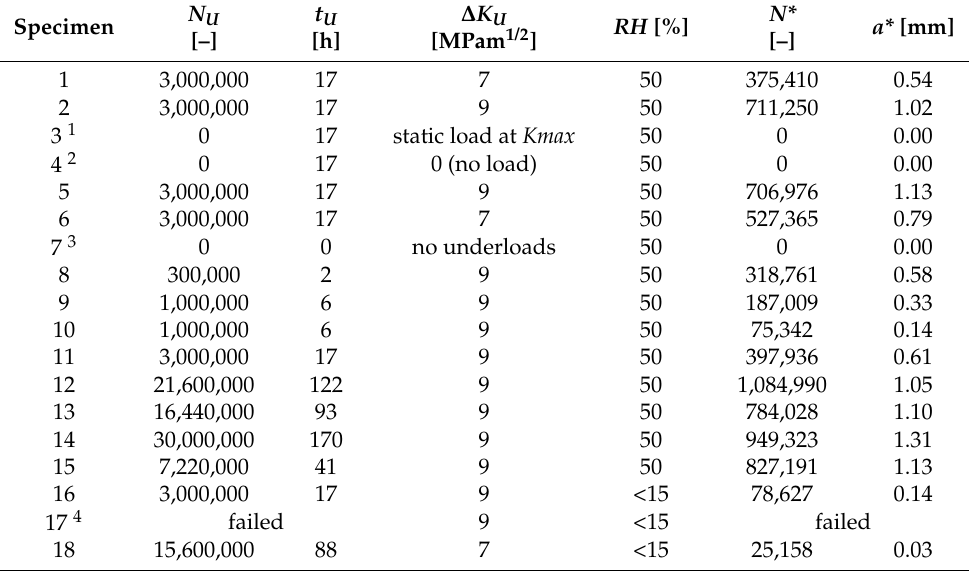
Table 3. Experimentally obtained results of the underload effect on crack propagation behavior: N U —number of applied underload cycles, t U —time related to underload cycling or time between the base loading segments, ∆ K U —level of underloads, RH —relative humidity, N* —number of influenced load cycles according to Equation (3), a* —influenced zone due to underloads according to Equation (4).